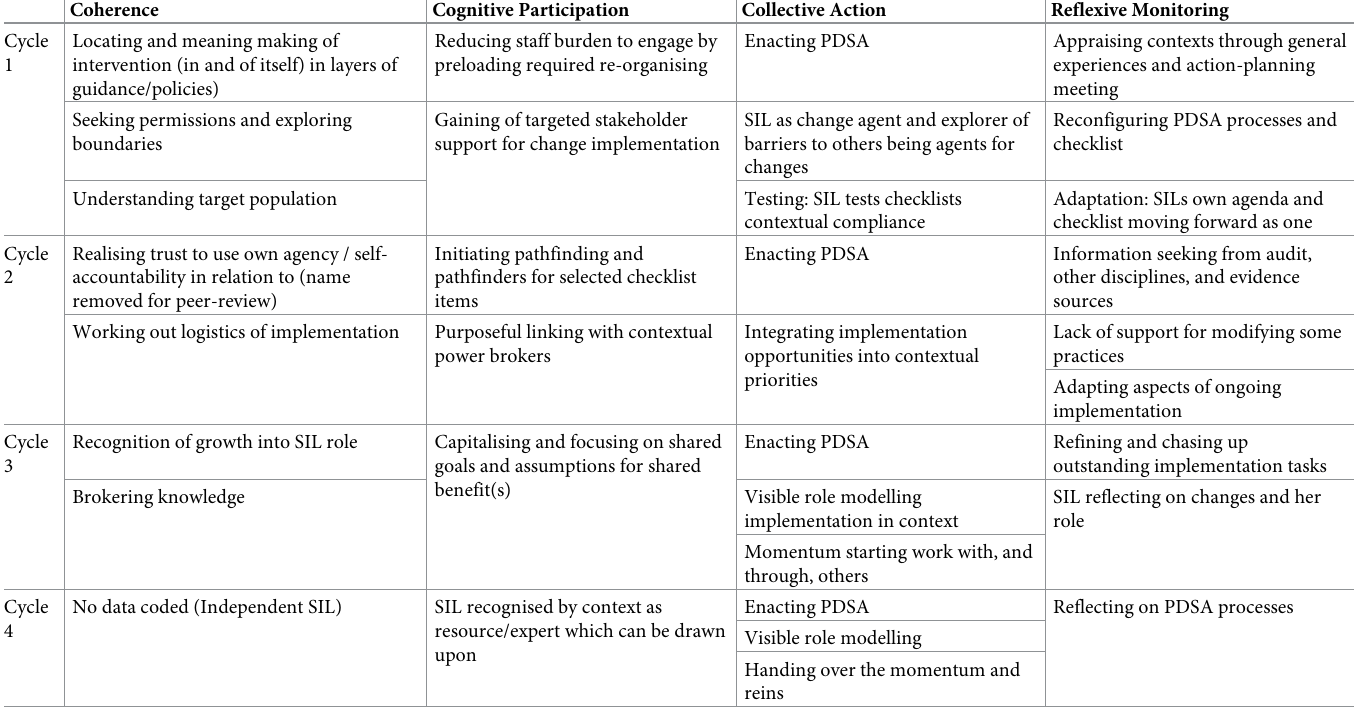
Table 2. Normalisation process at SITE